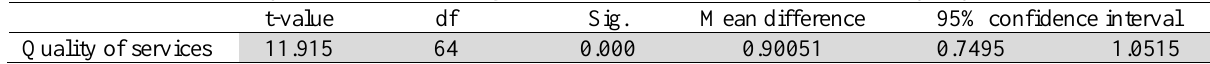
The results of one-way test on measuring the effect of CRM on customer loyalty.